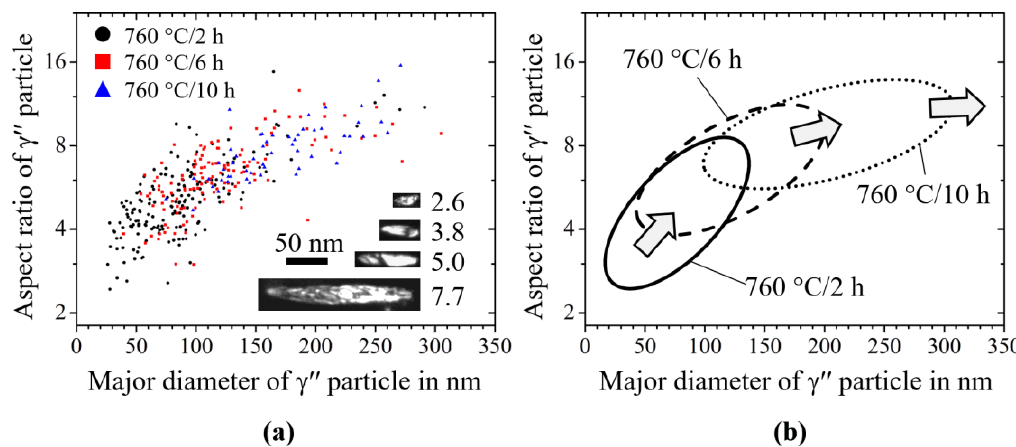
Figure 6. ( a ) Measured aspect ratio of γ′′ particles from the TEM images aged at 760 °C from 2 h to 10 h depending on the major diameter of the particle plate; ( b ) Schematic distribution of these aspect ratios of the γ′′ particles.